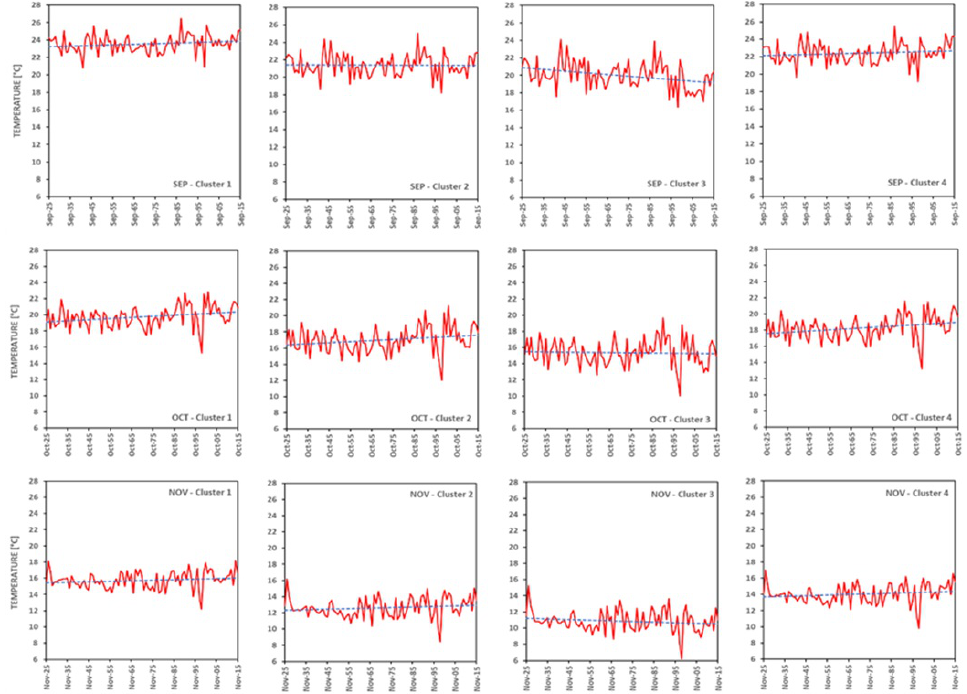
Figure 7. Trend of average monthly temperatures from 1925 to 2015 for each Cluster (quarter Sep– Oct-Nov).